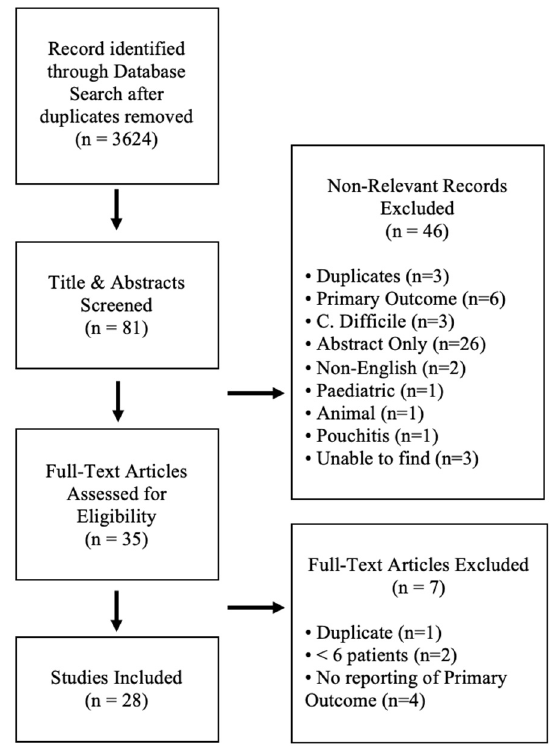
Figure 1. PRISMA flow chart of assessed studies.